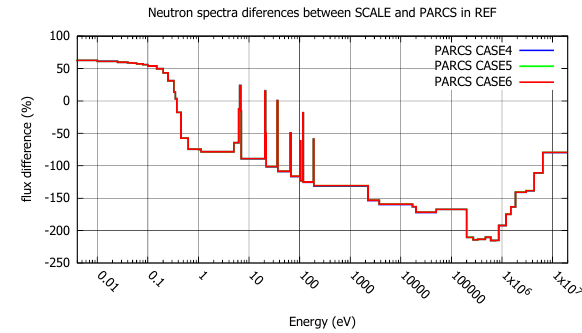
Figure 13. Relative difference in spectra between SCALE and PARCS calculation for DUM for 0.7%